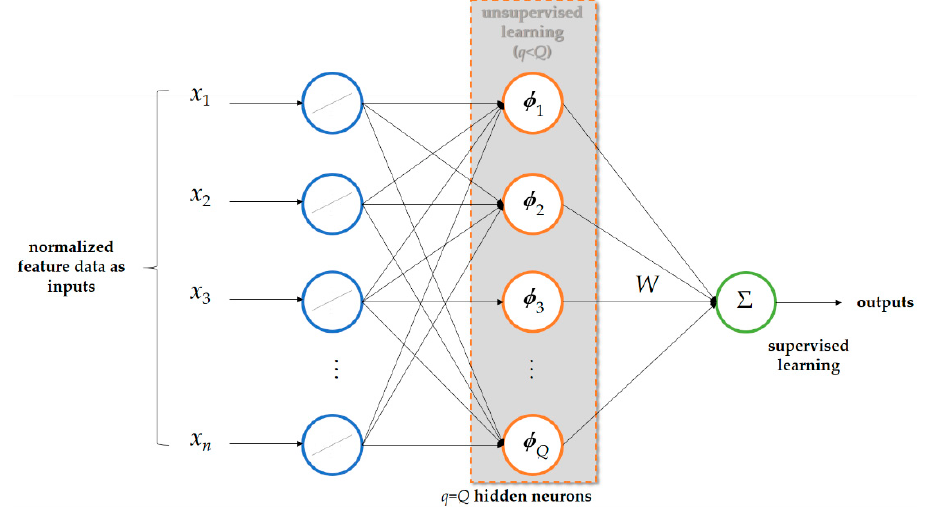
Figure 6. Standard radial basis function artificial neural network (RBF-ANN), lightweight AI.